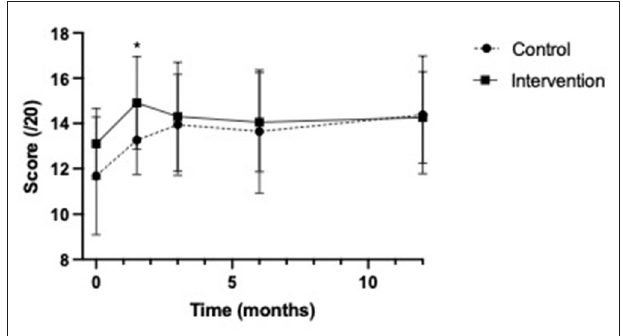
FIGURE 2 | Multiple choice question knowledge test score means. *p-value < 0.05, referring to the significant difference in scores between the control and intervention groups at 6 weeks post education.